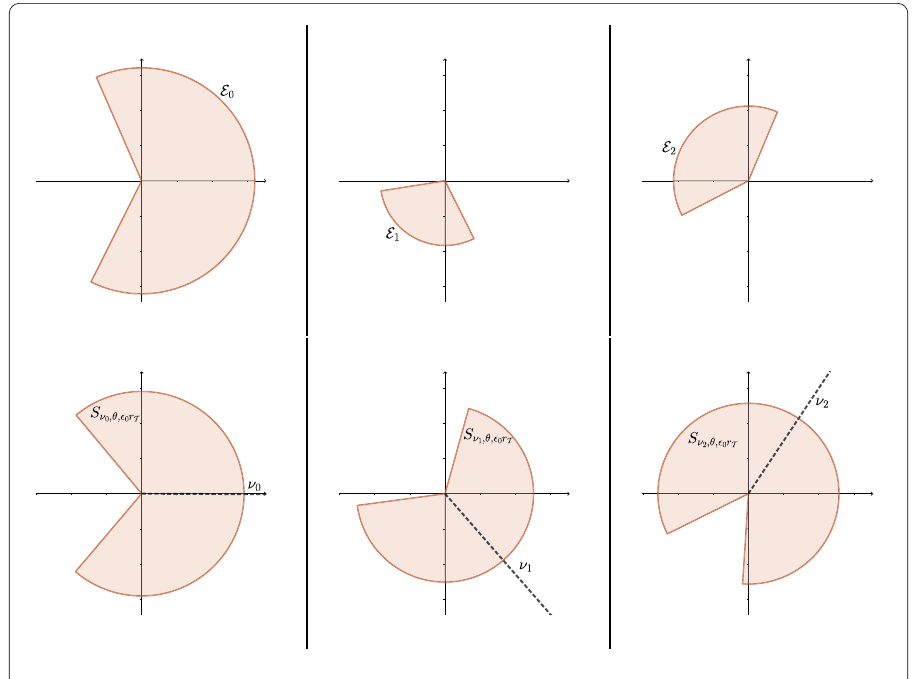
Figure 4 A configuration associated to the good covering in Fig.